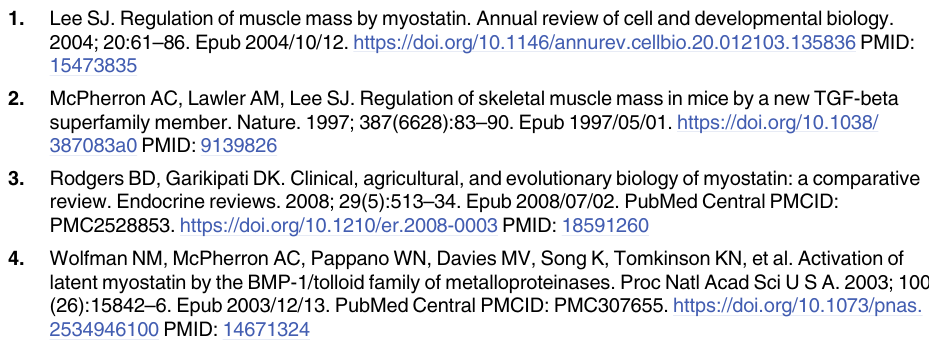
S1 Fig. SDS-PAGE analysis of MBP-Pro24-98 proteins after factor Xa cleavage. (A) After incubation of MBP-Pro24-98 with factor Xa, the total reaction mixture was centrifuged at 10,000 g for 3 min to soluble and in soluble fractions. Soluble fractions were subjected to 15% SDS-PAGE analysis under reduced (lane 1) and unreduced (lane 2) conditions, then visualized with Coomassie blue. (cid:3) , Pro24-98. (B) The supernatant was subjected to gel filtration, and frac- tions 16, 19, and 22 were subjected to SDS-PAGE analysis under reduced condition. Arrow head indicate Pro24-98. (C) MSTN-inhibitory capacity of purified Pro24-98 (f16) was mea- sured using the (CAGA) -luciferase reporter gene assay. The means of IC not sharing the 12 50 same superscript are different at P <